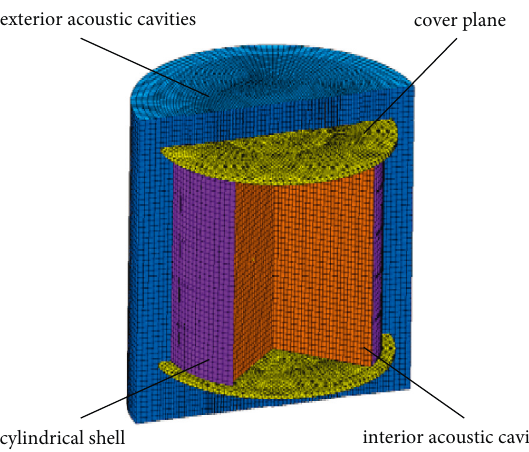
Figure 2: Finite element model map of cylindrical shell. Table 1: Material parameters of simulation computation.